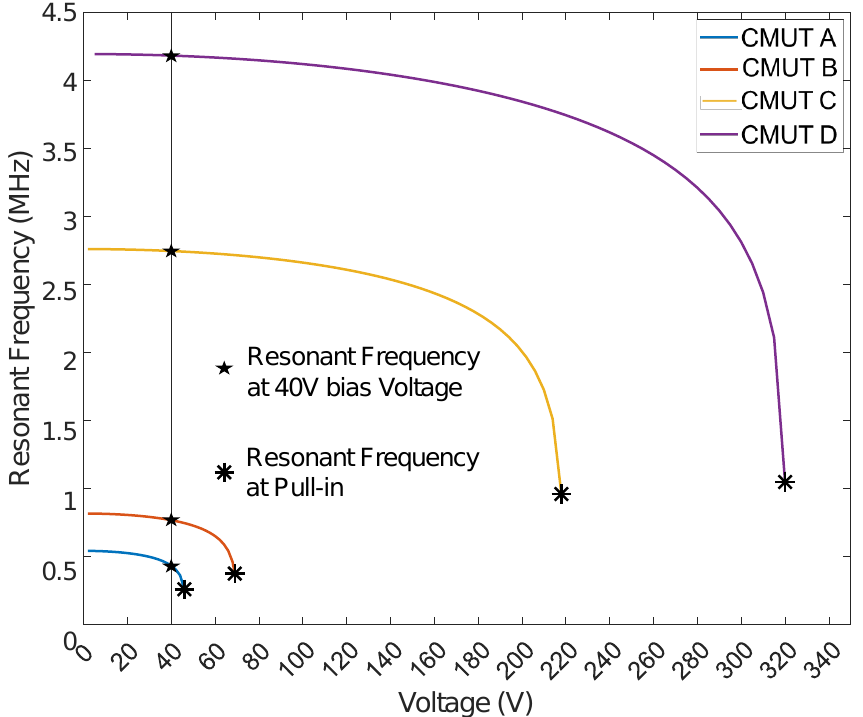
Figure 10. DC voltage vs. resonant frequency for